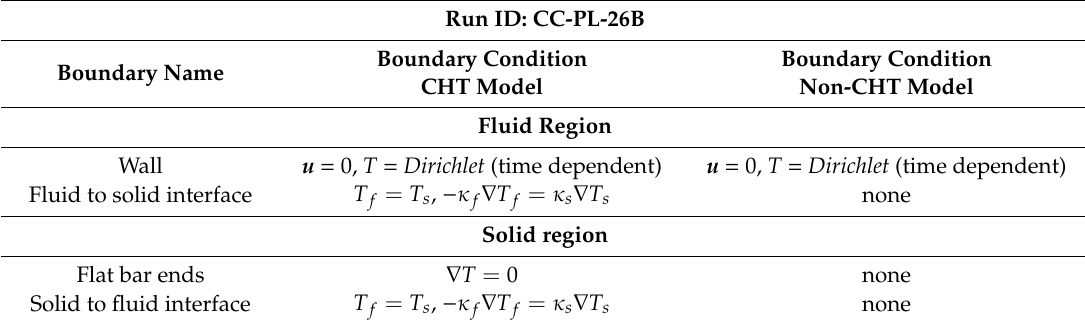
Table 2. Boundary conditions.